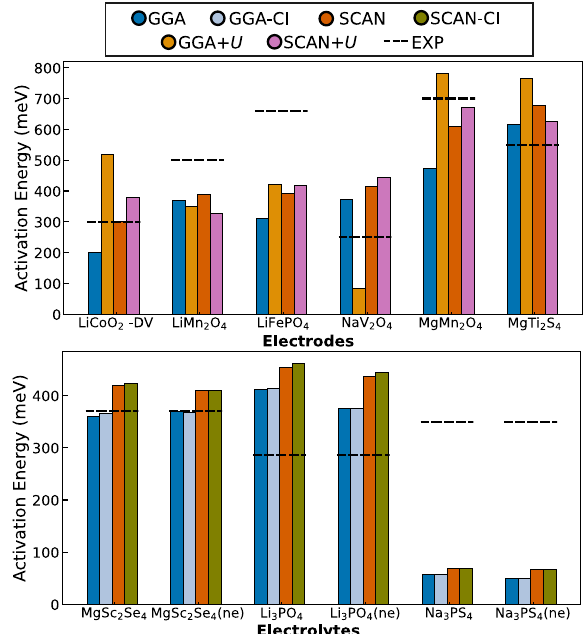
Fig. 2 Computed barriers, using different XC frameworks, for the electrodes (top panel) and solid electrolytes (bottom panel) considered in this work. Horizontal dashed lines indicate experi- mentally reported values. “ ne ” in the electrolytes panel indicates the inclusion of UBC (i.e., NELECT) in the NEB calculation, while bars corresponding to “ CI ” highlight the usage of the climbing image framework. Barriers plotted for Li 3 PO 4 are for the 1(d) → 2(c) hop. “ DV ” in LiCoO 2 -DV stands for the divacancy hop